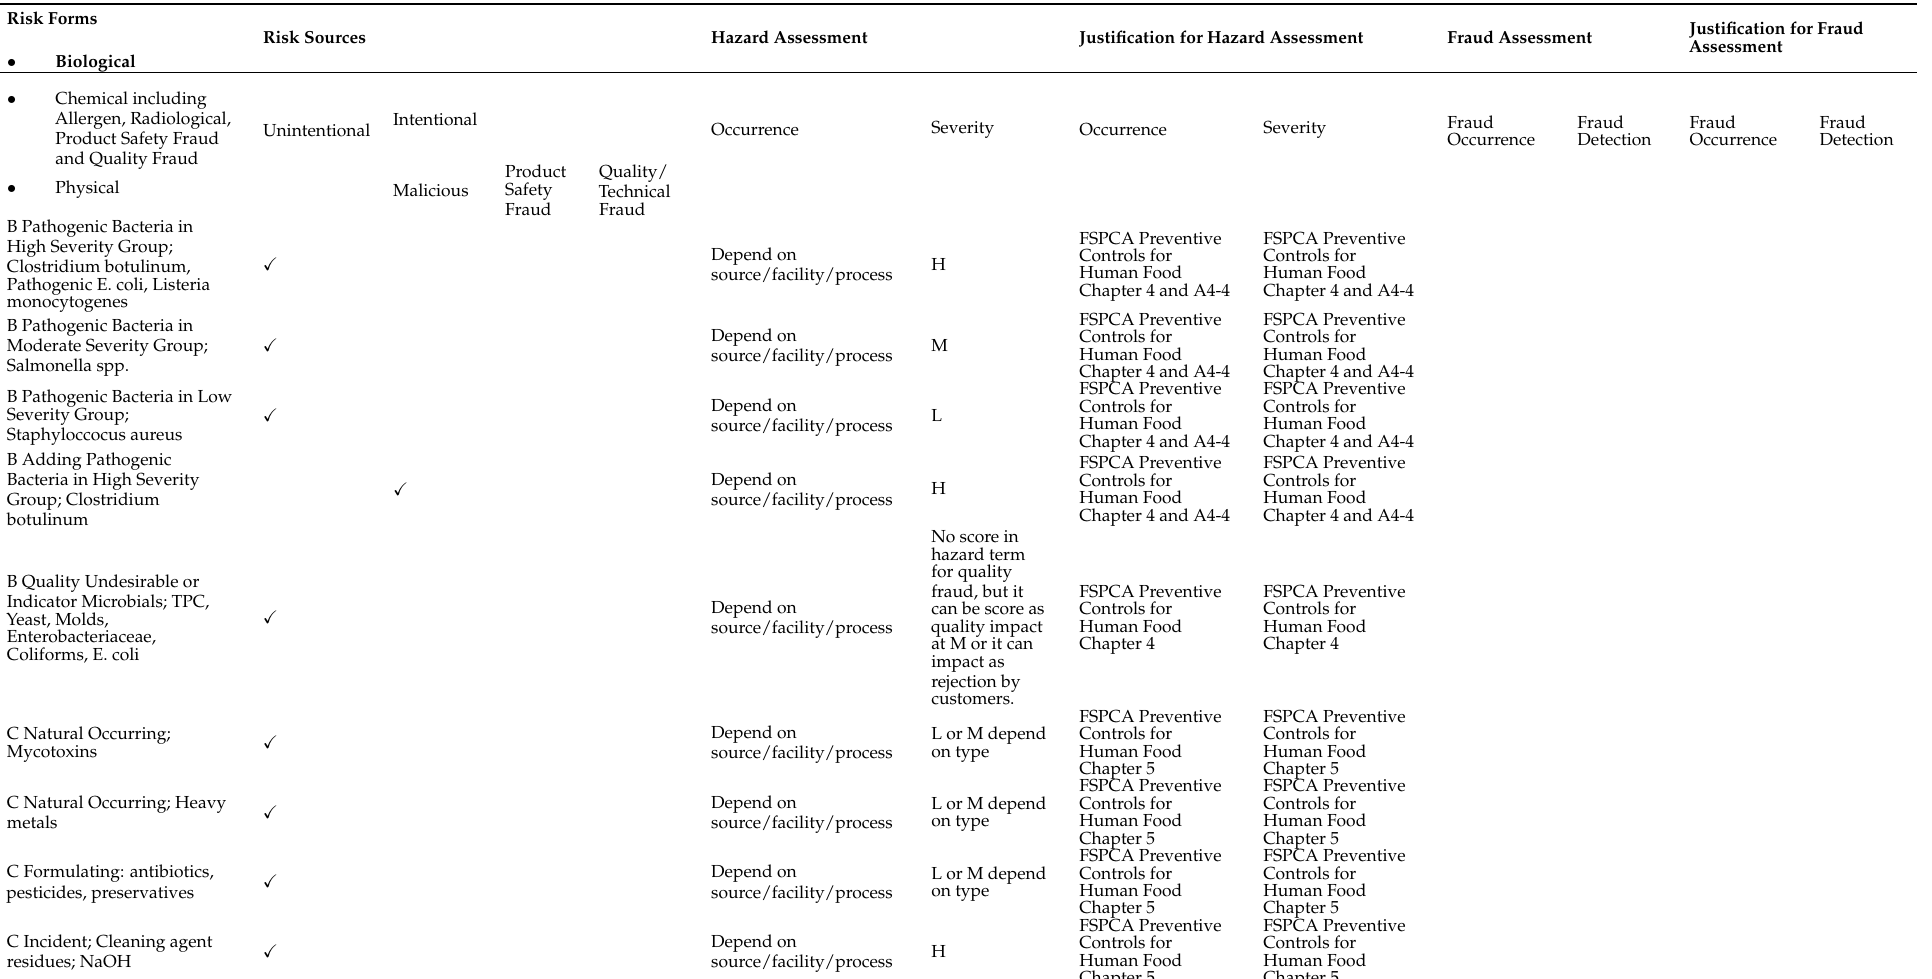
Table 3. General food risk scoring